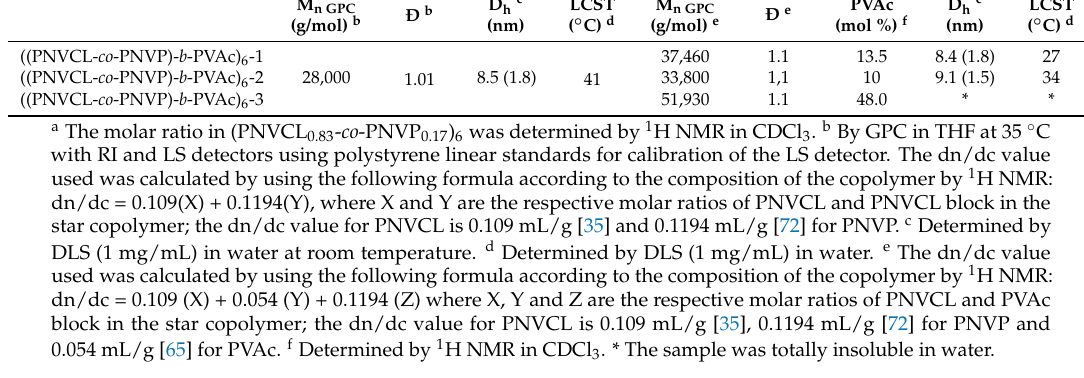
Table 3. Characteristics of the star ((PNVCL- co -PNVP)- b -PVAc) 6 copolymers.